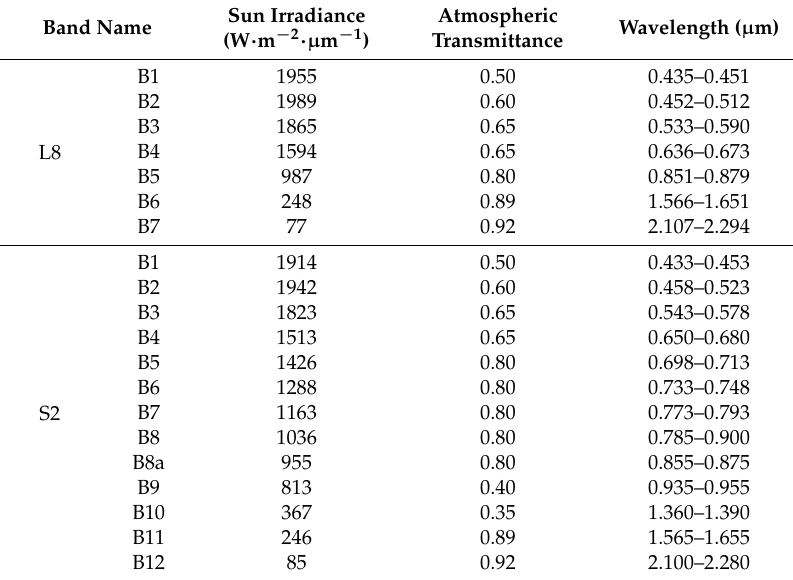
Table 3. Sun irradiances and atmospheric transmittance values used for images calibration. Atmospheric transmittance values are the ones proposed in literature for a reference mid-latitude low-hazy atmosphere